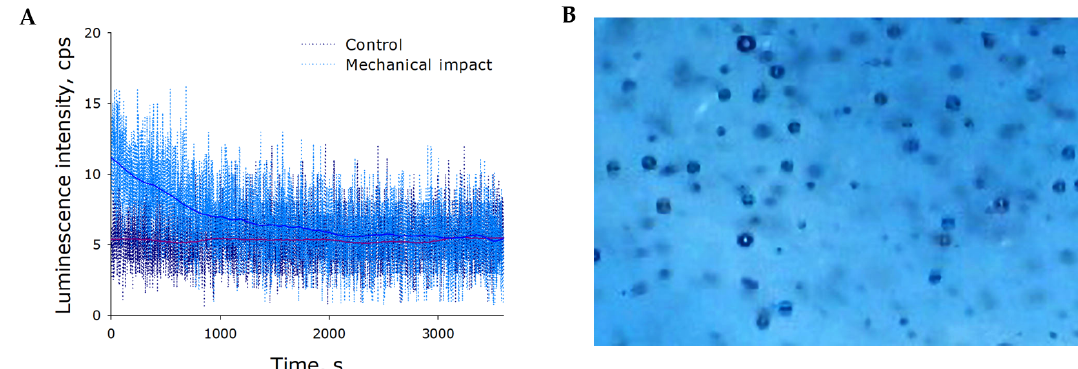
Figure 1. The effect of mechanical stress (30 Hz, amplitude of 5 mm, for 5 min) on intrinsic water luminescence ( A ) and gaseous phase distribution ( B ). The photograph was taken shortly after the mechanical treatment.